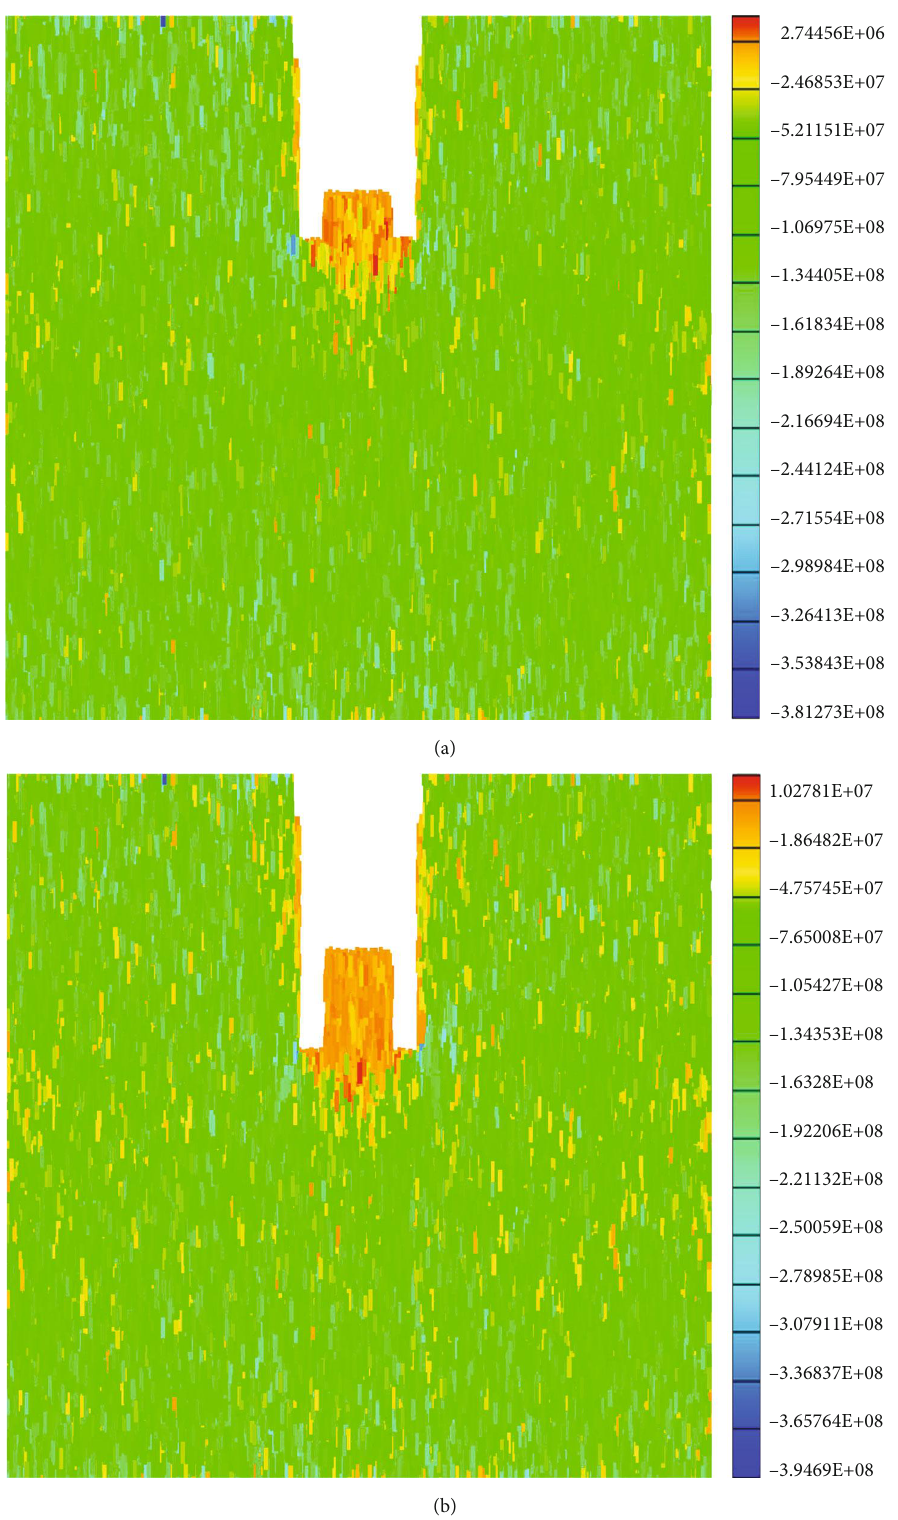
Figure 11: Typical stress cloud pictures of the model under di ff erent drilling depths. (a) h = 3 : 00 cm . (b) h = 4 : 00cm